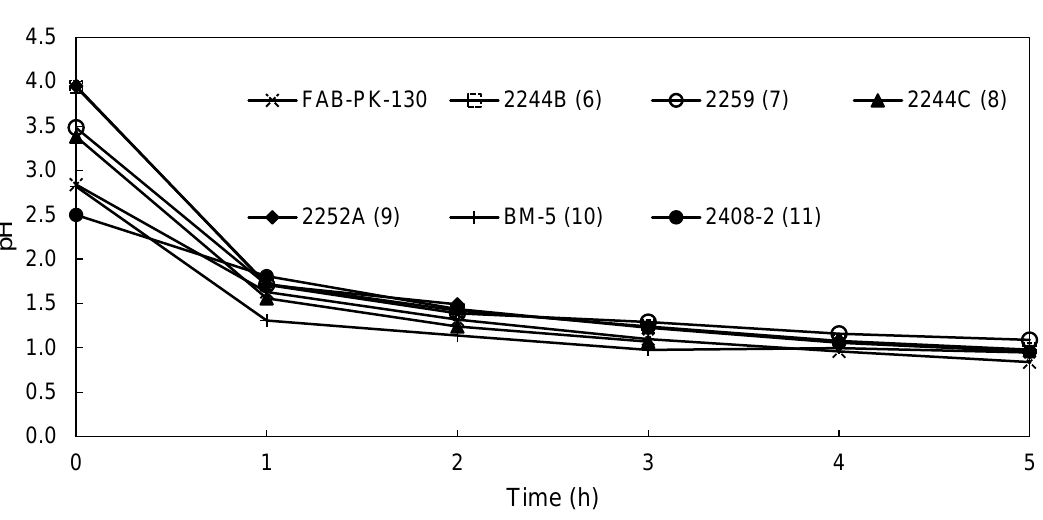
Figure 6. Change in the catholyte pH for membranes FAB-PK-130, 2244B (6), 2259 (7), 2244C (8), 2252 A (9), BM-5 (10), and 2408-2 (11) during EW.